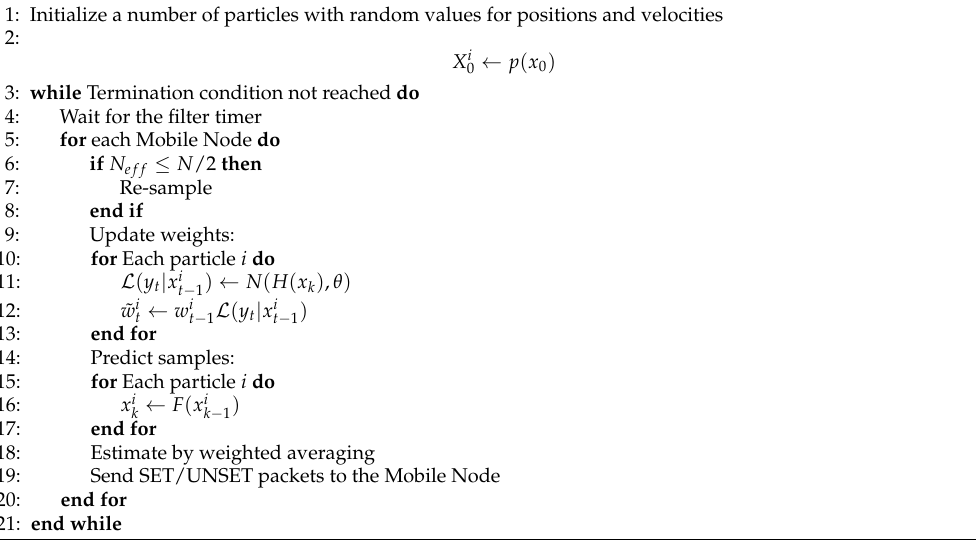
Algorithm 1 SDMob’s algorithm with Particle